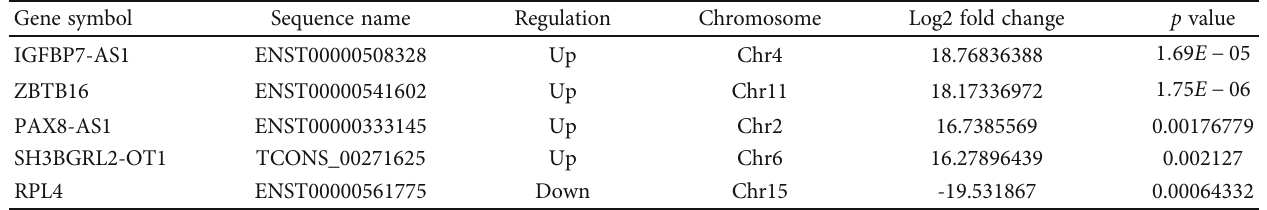
Table 3: Characteristics of the top fi ve di ff erently expressed lncRNAs on day